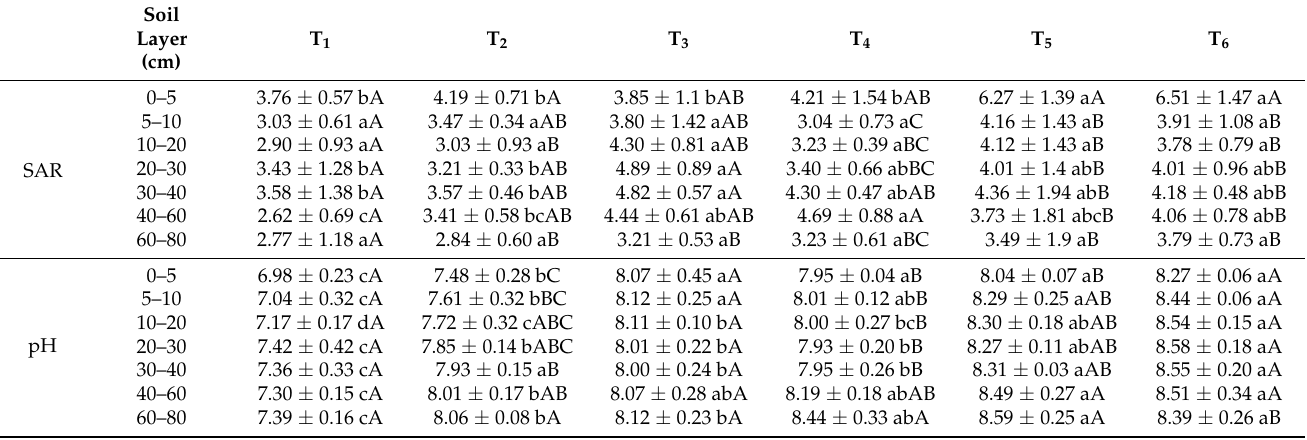
Table 3. Soil SAR and pH values during the freeze–thaw